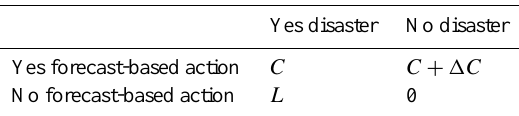
Table 3. Contingency table of costs and losses as outcomes of forecast-based